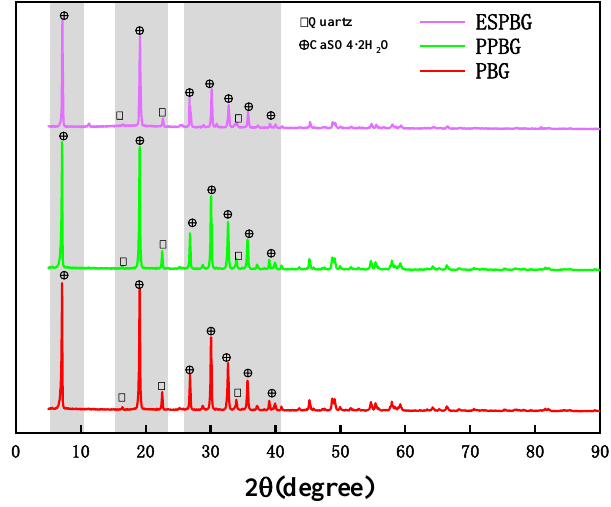
Figure 13. XRD patterns of the PBG, PPBG, and ESPBG. The ESPBG contained all of the peaks of PBG and PPBG, but the peak intensities were relatively lower in comparison with those of PBG and PPBG. The results showed that the addition of a small amount of air-entraining agent in PPBG only formed bub- bles, making the PBG form a good pore structure, and the peak value of the main com- ponents changed little. However, due to the adsorption of 26.06% paraffin in ESPBG, the peak value of the material combined with paraffin was reduced [16]. Therefore, the peak